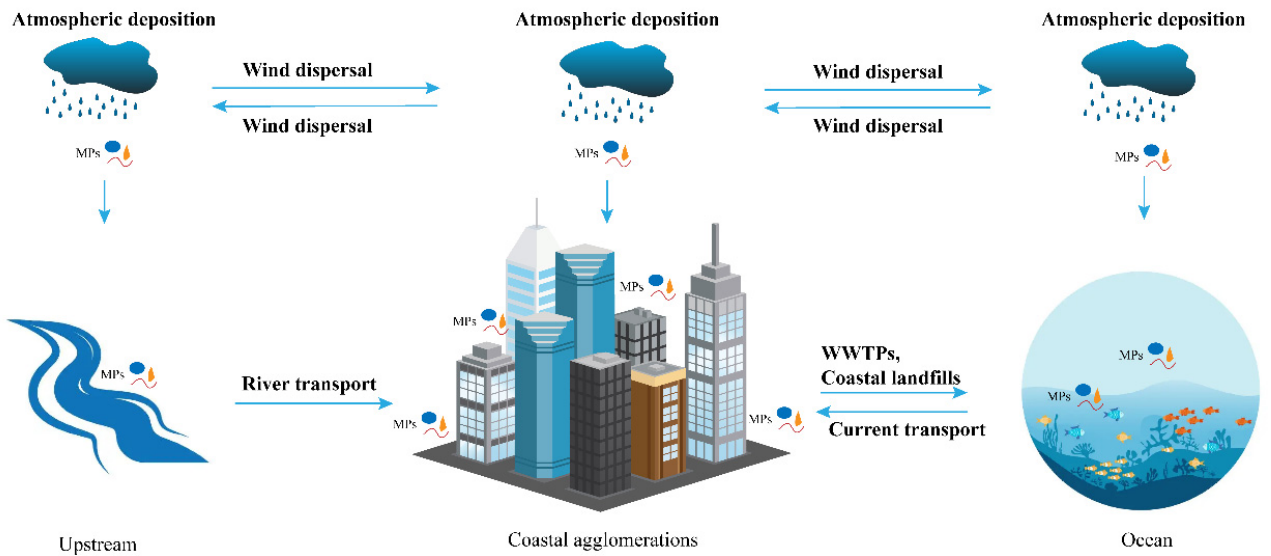
Figure 3. Microplastic input and output pathways in coastal agglomerations (symbols from the IAN/UMCES Symbol and Image Libraries were used).